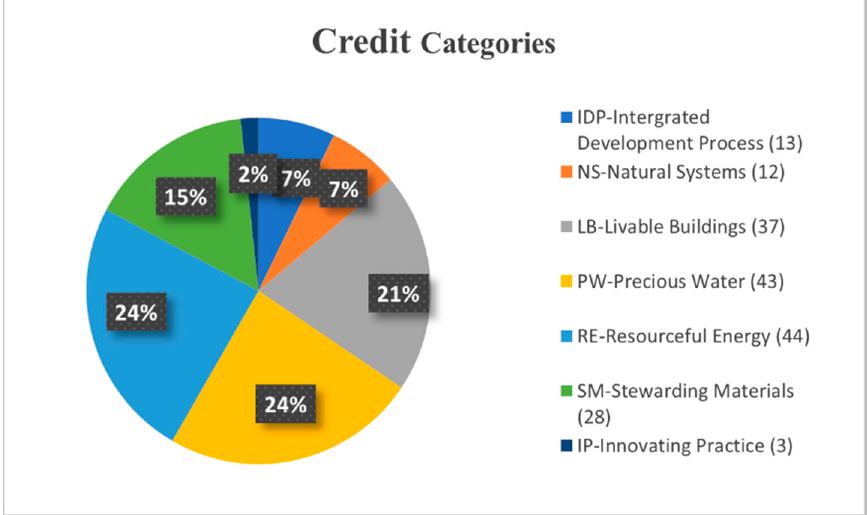
Figure 3. Credit categories of Pearl Rating System.